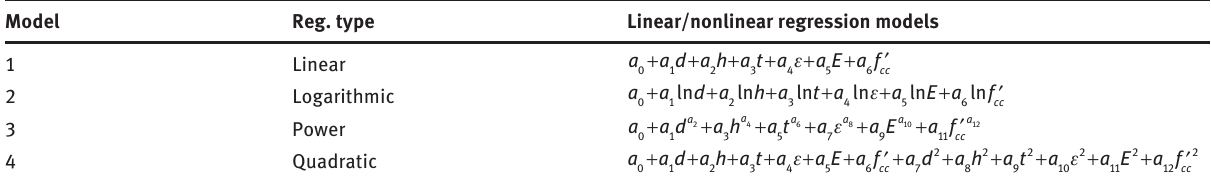
Table 3 Multiple regression models for strength estimation of CFRP-confined concrete cylinders. Model